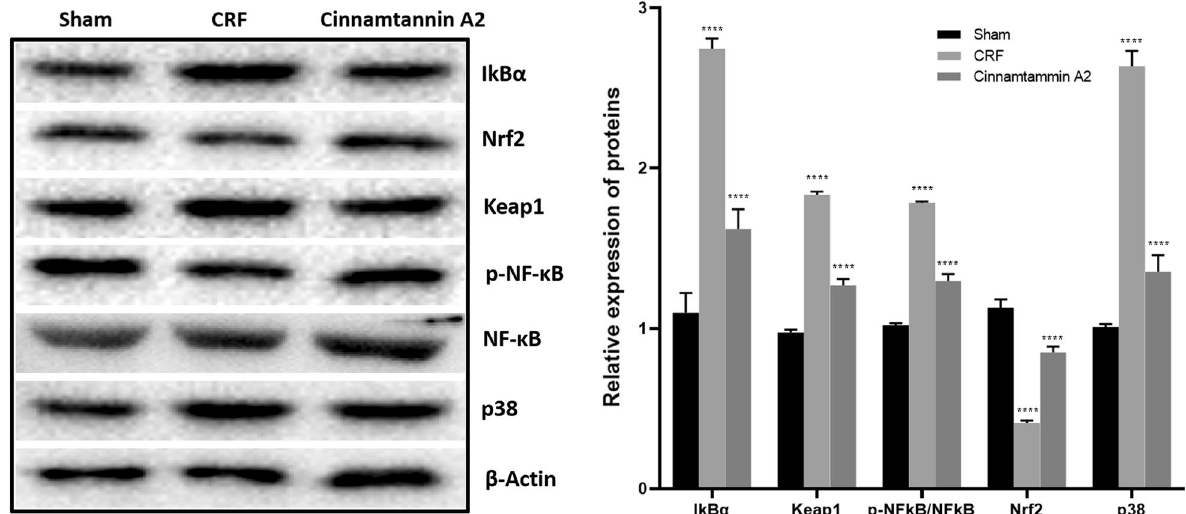
Fig. 6 Effect of Cinnamtannin A2 on the expression of IkBα, Keap1, Nrf2, p-38 and p-NF-κB proteins in the kidney tissue of 5/6 nephractomized rats. Mean SD (n 10); ## p < 0.01 than Sham operated group; **p < 0.01 than CRF group ± =